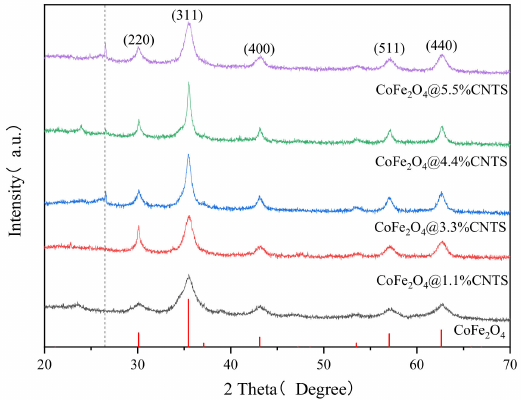
Figure 1. XRD patterns of the different CoFe 2 O 4 @CNTs composites.